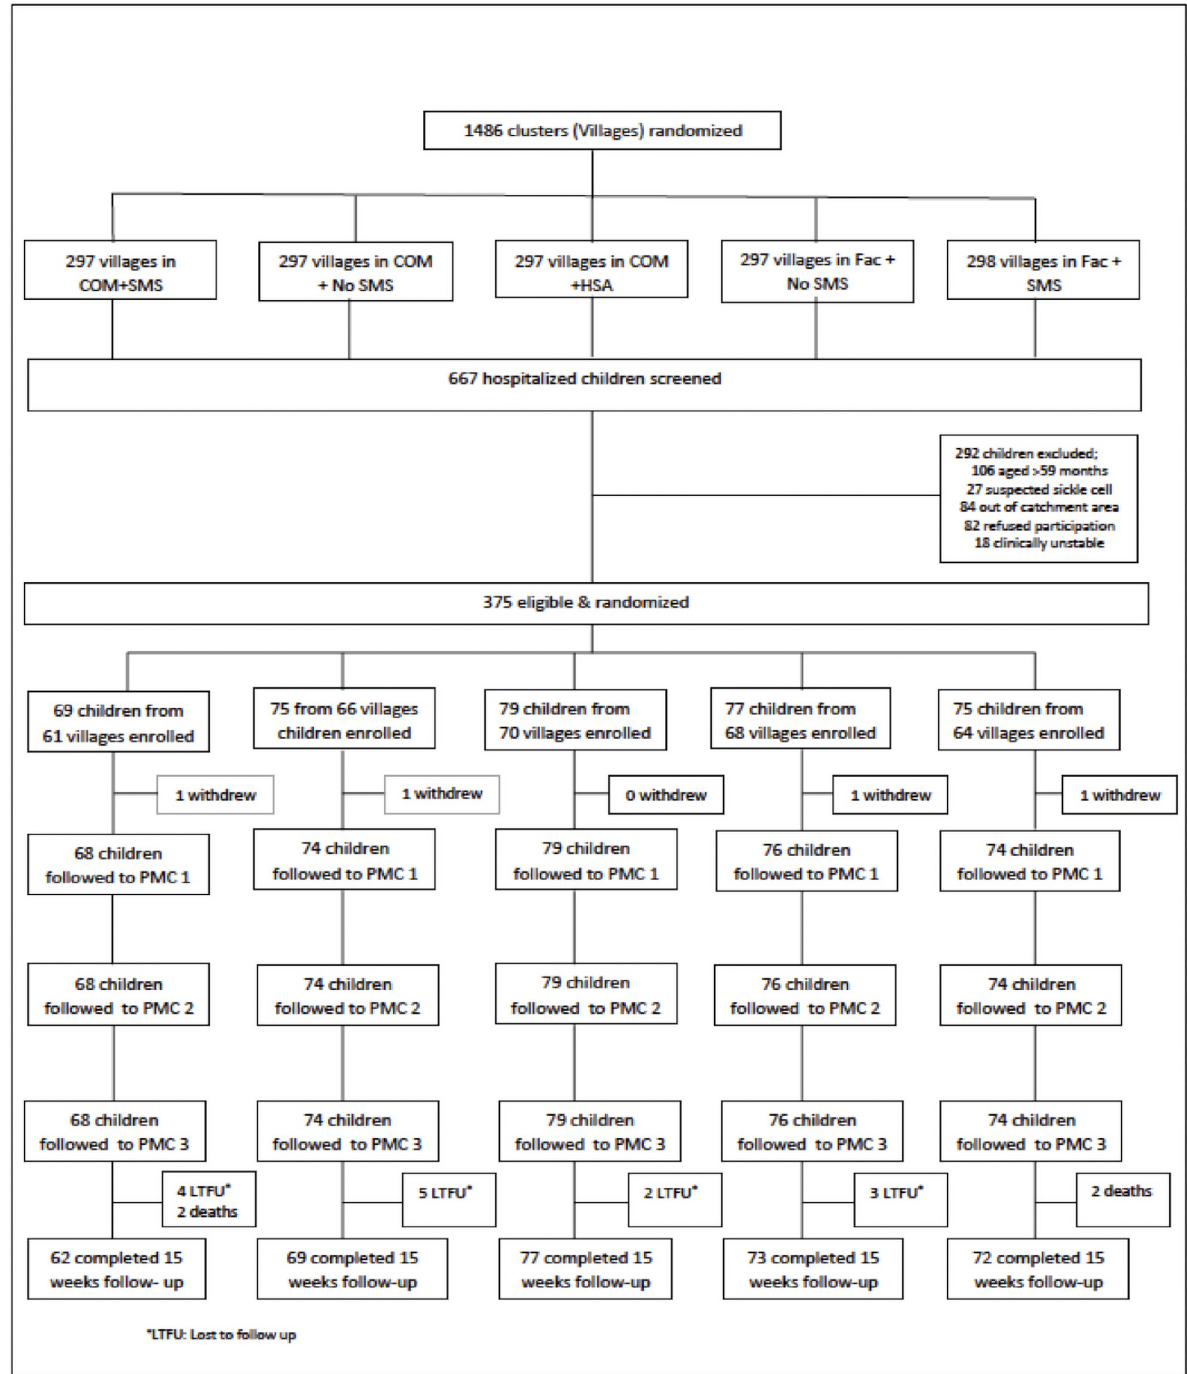
Fig 2. Consolidated Standards of Reporting Trials (CONSORT) flow diagram of the PMC delivery trial.